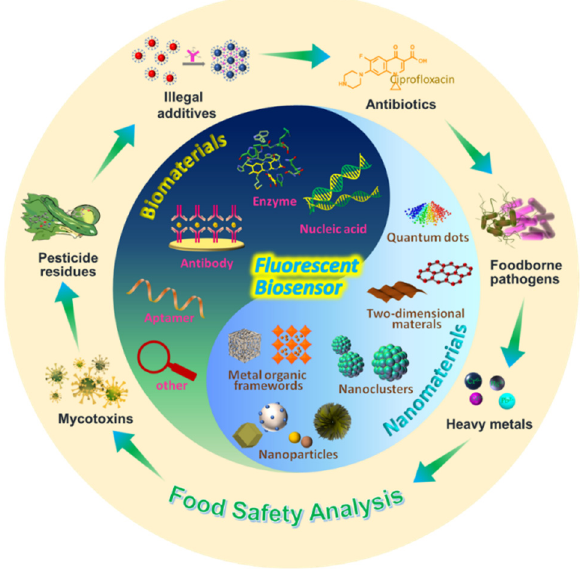
Figure 2. Schematic illustration of nanomaterial-based fluorescent biosensors for food safety analysis.